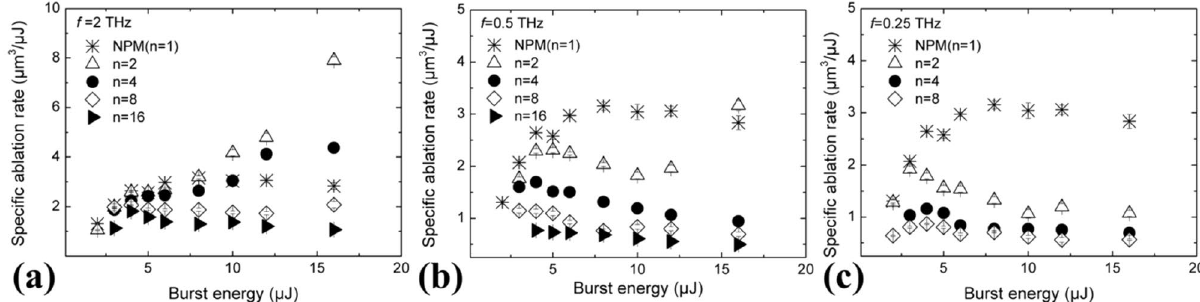
Figure 5. Specific ablation rate as a function of the burst energy, in case of bursts of 2, 4, 8, and 16 pulses at ( a ) 2 THz, ( b ) 0.5 THz and ( c ) 0.25 THz. NPM is shown for